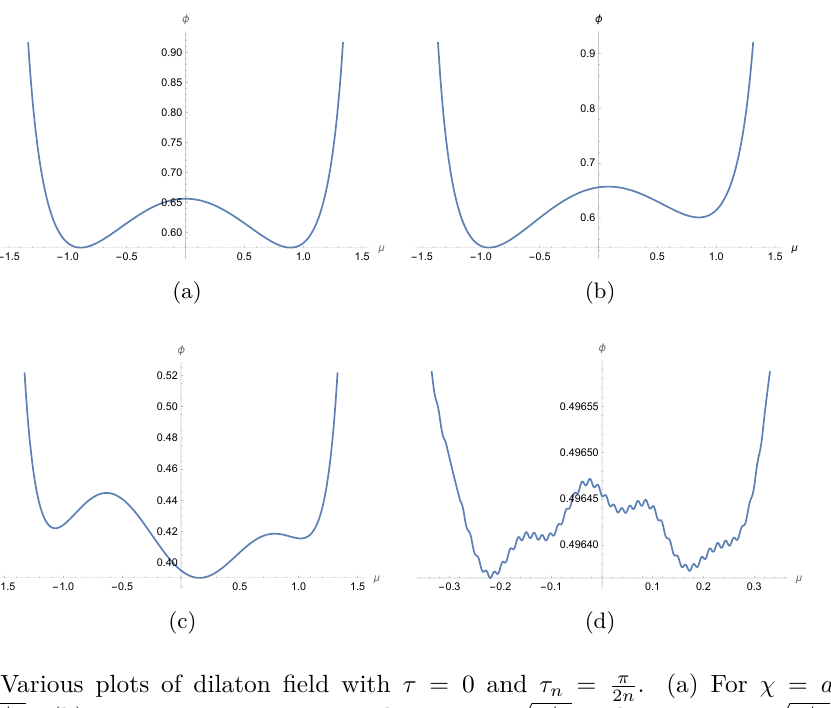
Figure 5 . Various plots of dilaton field with τ = 0 and τ n = π . (a) For χ = a 1 χ v 2 n p p a 1 = 0 . 9 8 /π . (b) For χ = a 1 χ v + a 2 χ v with a 1 = 0 . 9 8 /π and a 2 = − 0 . 02 1 2 p p χ = a 1 χ v + a 2 χ v + a 3 χ v with a 1 = 0 . 094 8 /π , a 2 = 0 . 94 8 /π and a 3 = − 0 . 094 1 2 3 p p χ = a 151 χ v + a 200 χ v with a 1 = 0 . 0316 8 /π , a 2 = 0 . 8888 8 /π 151 200 2